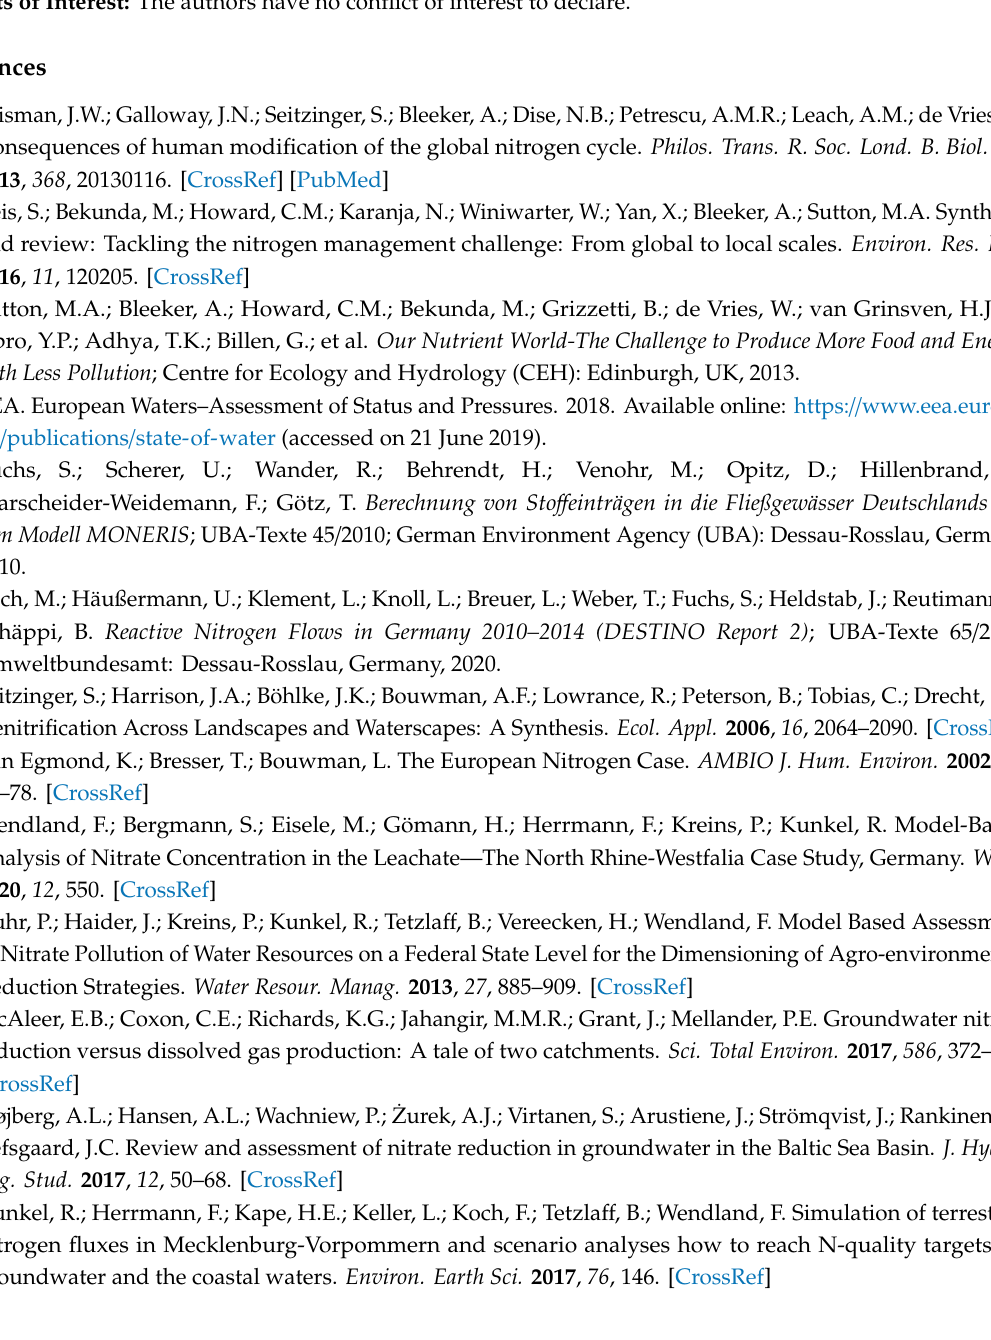
Table S1: Post-Hoc-Test results aquifer type, Table S2: Post-Hoc-Test results consolidation, Table S3: Post-Hoc-Test resultsrocktype, TableS4: Post-Hoc-Testresultsgeochemicalrocktype, TableS5: Post-Hoc-Testresultsconductivity, Table S6: Post-Hoc-Test results redox